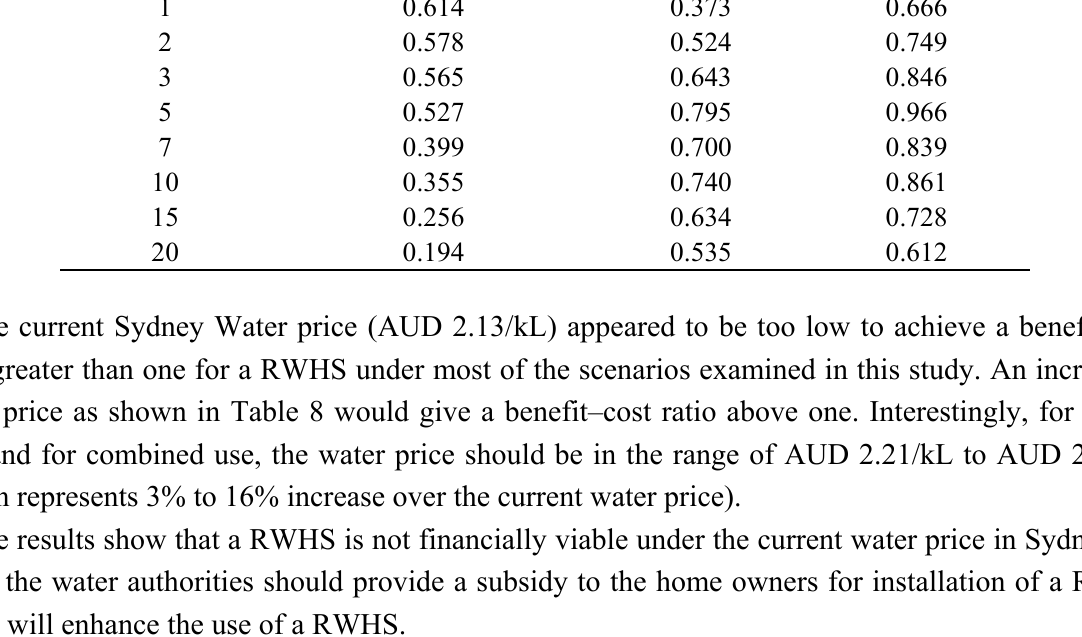
Table 7. Benefit–cost ratio values at Hornsby (based on current Sydney water price of AUD 2.13/kL). Tank size (kL) Toilet and laundry use Irrigation